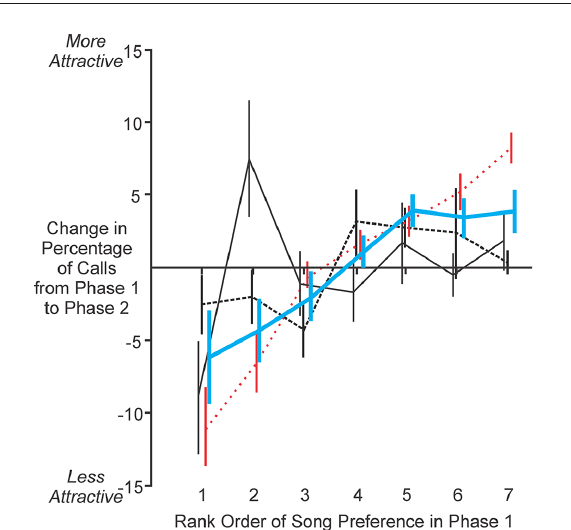
FIGURE6 NC lesioned females expressed reduced strength of preference among songs of different males. For experimental birds (thick blue solid line), data were arranged in a linear manner with significantly positive slope (linear regression, F = 28.14, slope = 1.84, p < 0.001), indicating that lesioning NC caused birds to become less choosy for songs that they previously found attractive or unattractive (detailed in “Results” Section). In contrast, data from control birds (thin black solid line; linear regression, F = 1.43, p = 0.24) and sham birds (thin black dashed line; linear regression, F = 1.30, p = 0.26) had slopes that